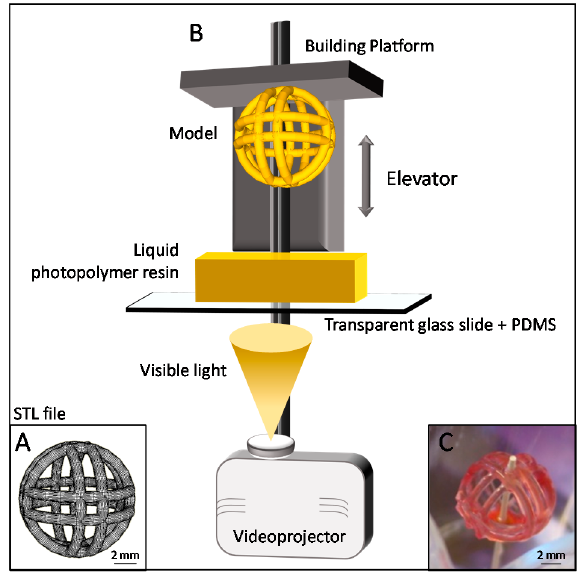
Figure 3. Fanciful ball printing. The digital light processing (DLP) printing set-up and concept. Images of each layer are projected in a liquid resin batch to generate polymerization. Additive manufacturing process—Fanciful ball. ( A ) Standard Tessellation Language (STL) file; ( B ) DLP process; ( C ) 3D-printed object.